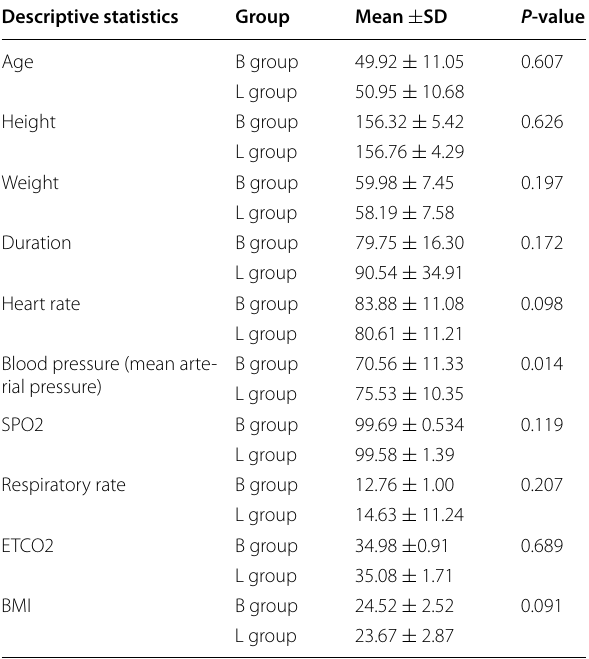
Table 1 Association between descriptive statistics and type of gel used Descriptive statistics